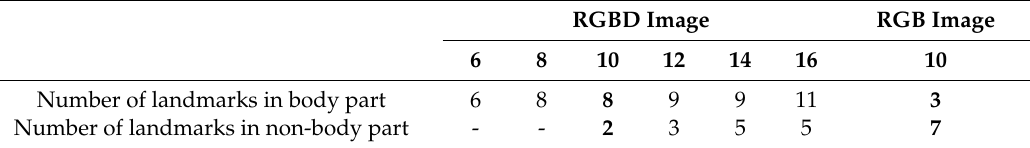
Table 2. Location of landmark